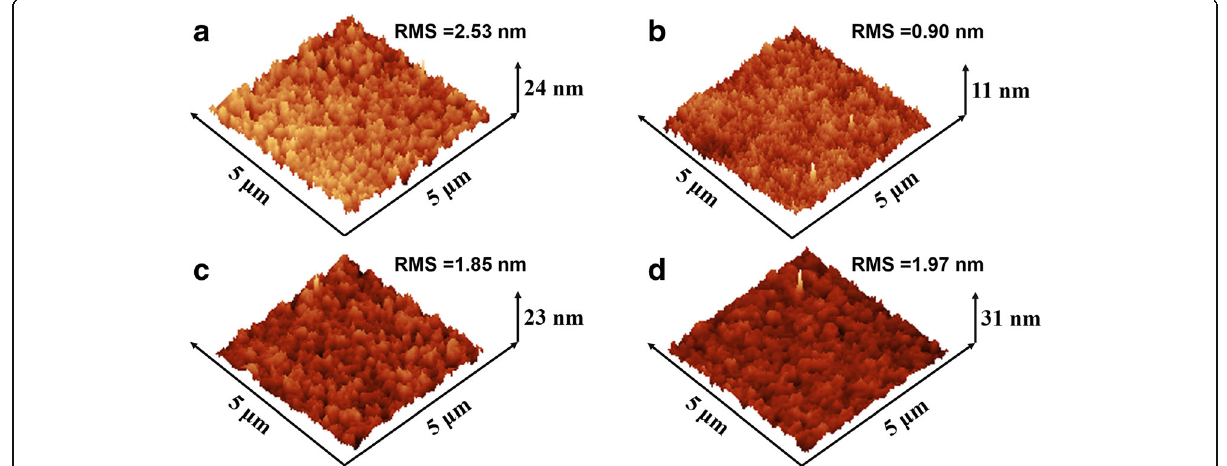
Fig. 4 AFM morphology images of PEDOT:PSS films: a pristine PEDOT:PSS and b – d treated with MeOH, EtOH, and IPA,